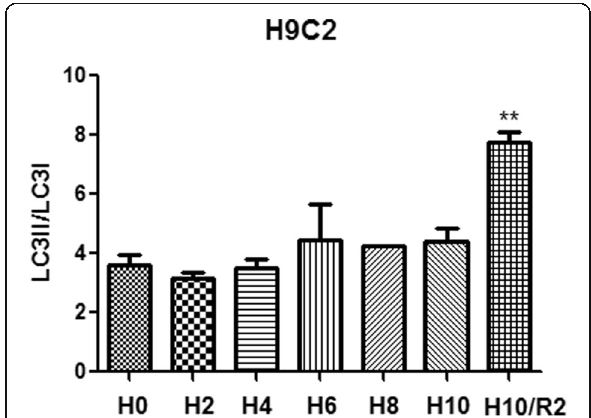
Fig. 5 The expression of autophagy marker proteins at different time points of H10/R2. H9C2 cells were cultured under hypoxia for 0 h (H0), 2 h (H2), 4 h (H4), 6 h (H6), 8 h (H8) and 10 h (H10), and reoxygenated for 2 h (H10/R2), respectively. The expression of LC3, an autophagy marker, was assayed. The data were represented as mean ± SD of three independent experiments. Tubulin protein was used as a loading control. ** p < 0.05 vs H0